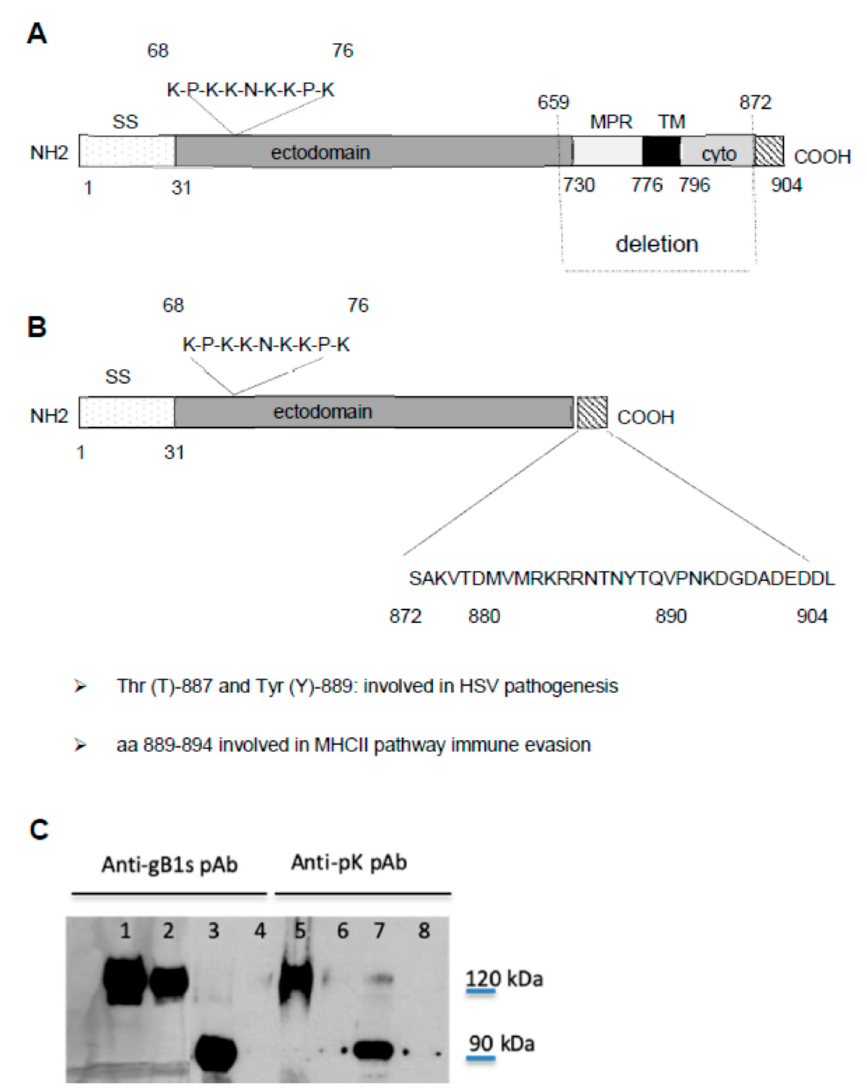
Figure 1. Schematic representation of KOS gB1 ( A ) and gB1s ( B ) and western blot analysis using anti-gB1s and anti-pK pAbs ( C ). SS, signal sequence; MPR, membrane-proximal region; TM, trans-membrane region; ectodomain and (cyto) cytodomain regions. Schematic representation of ( A ) full-length gB1 and ( B ) gB1s secreted protein obtained from the gB1 gene encoding the MPR and the TM regions, after having deleted 639 nucleotides and reconstructed the gene with the ectodomain and COOH cytodomain. The sequence from 872 to 904 represents the terminal sequence of the cytodomain present in gB1s. Sequence 68 to 76 is the lysine-rich region (pK) that binds HSPG. ( C ) WB analysis of gB1s recombinant protein ( ≈ 90 kD) using the anti-gB1s and anti-pK pAb (lane 3 and 7) and, as controls, full length KOS wt gB1 (120 kDa) (lane 1 and 5) or gBpK − mutant (lane 2 and 6) using the anti-gB1s and anti-pK pAbs respectively and mock uninfected cells tested with anti-gB1s and anti-pK pAbs (lanes 4 and 8). The anti-pK pAb is not able to recognize the KOS gBpK − mutant.